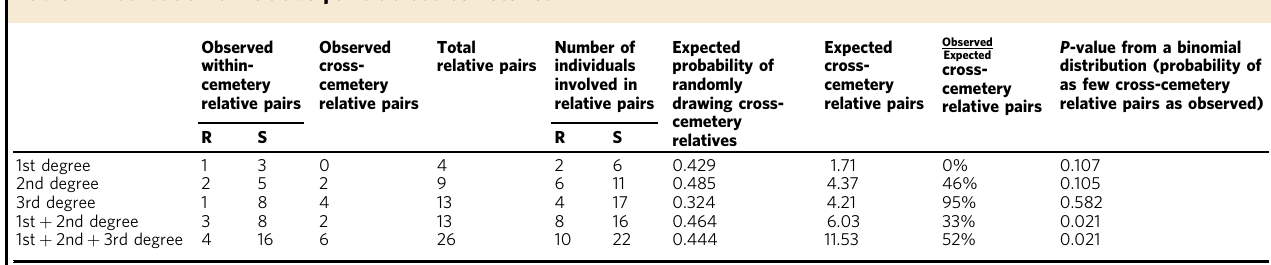
Table 1 Distribution of relative pairs across